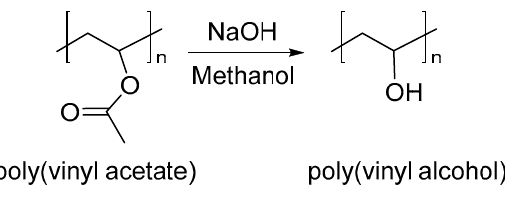
Figure 7. Synthesis of PVA.